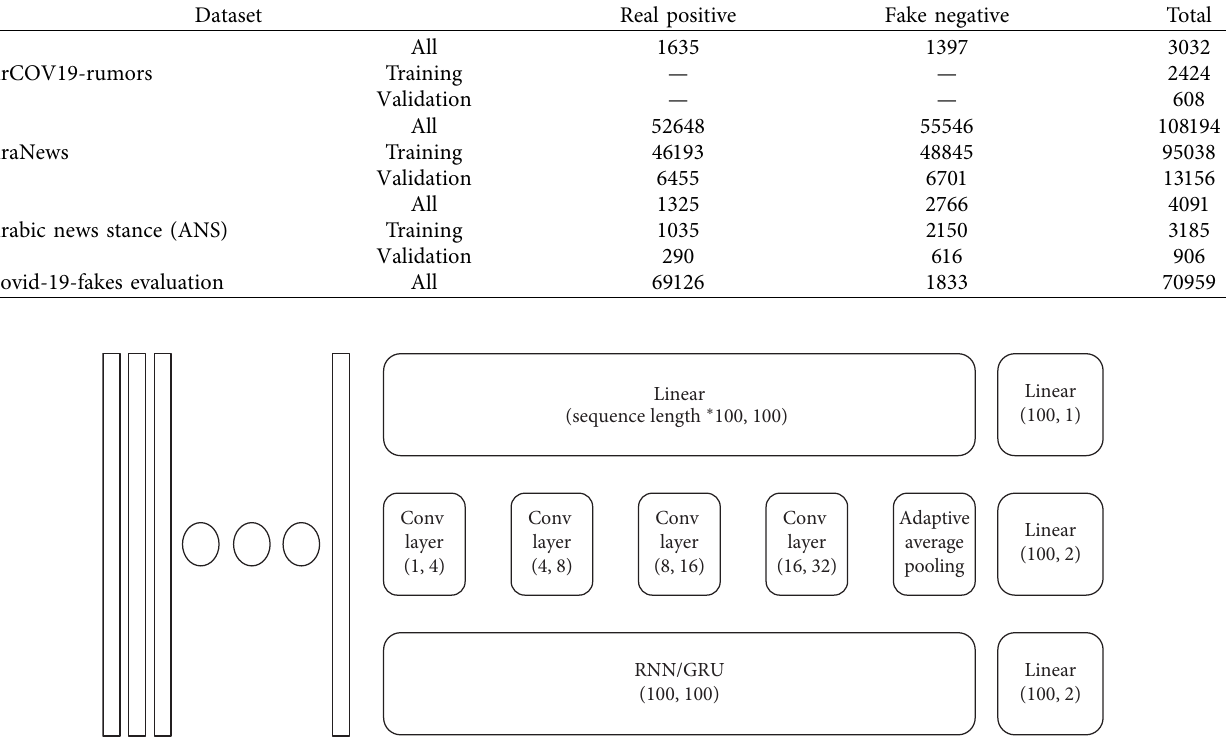
Table 1: Details of Arabic dataset statistics used in this study.